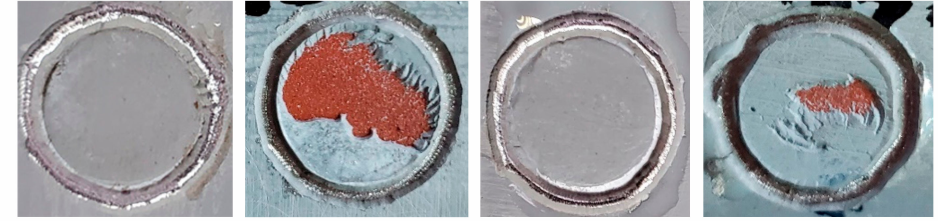
Figure 15. The nature of destruction in the zone after pull-off test.